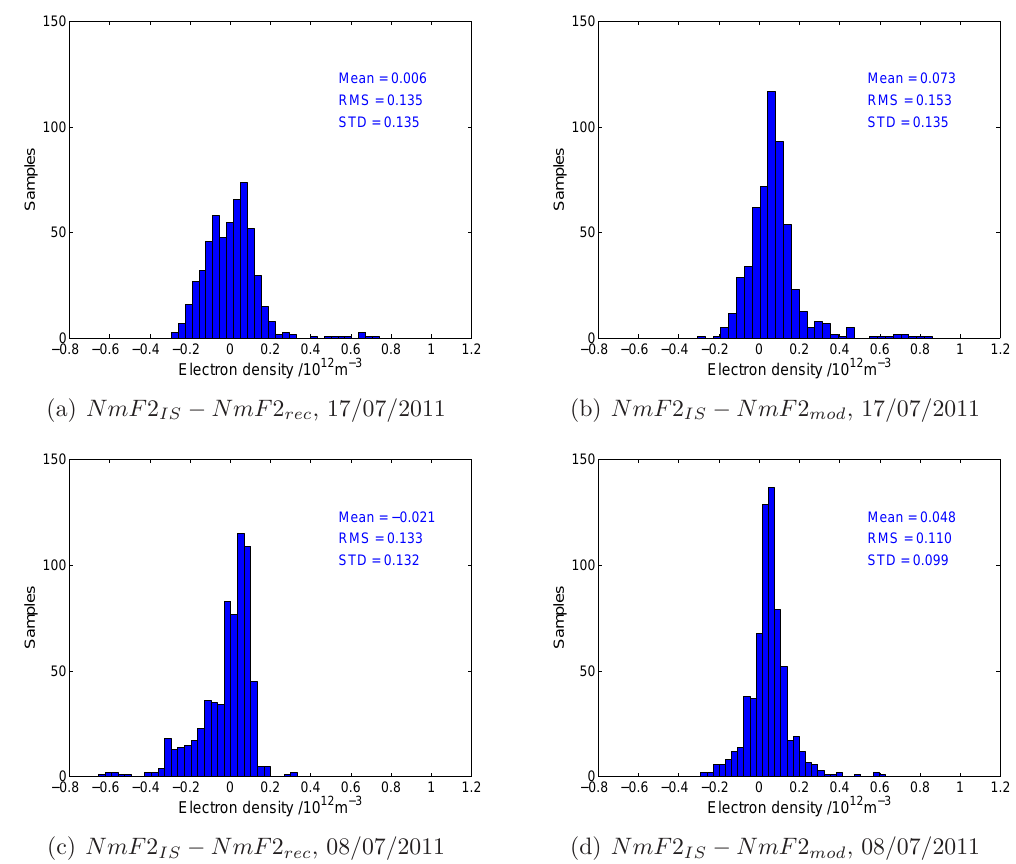
Fig. 7. Histograms of the reconstruction residuals (left side) and model residuals (right side). 5 ◦ longitude and time resolution of 5 min. The reconstructed electron density maps are offered to users via the opera- tional data service SWACI (http://swaciweb.dlr.de) at DLR